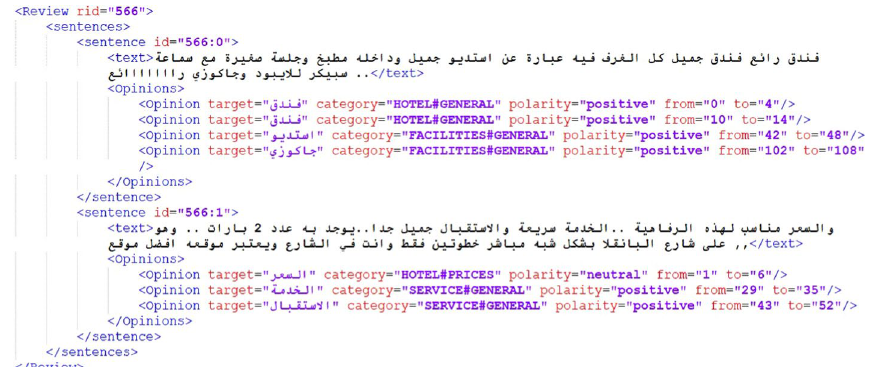
Fig. 4 Example of the Arabic hotels dataset schema